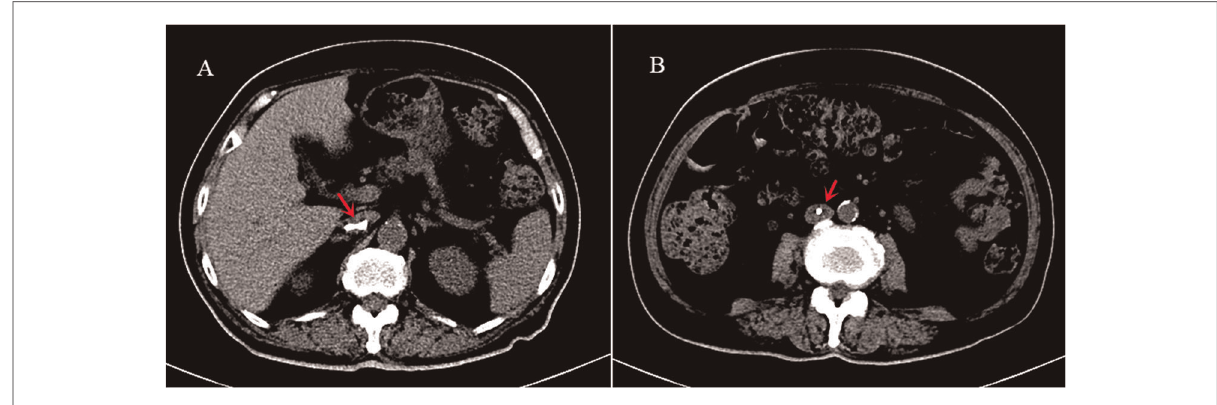
FIGURE 3 Computed tomography revealing the double J stent malposition (arrow). The proximal coil was at the level of upper renal